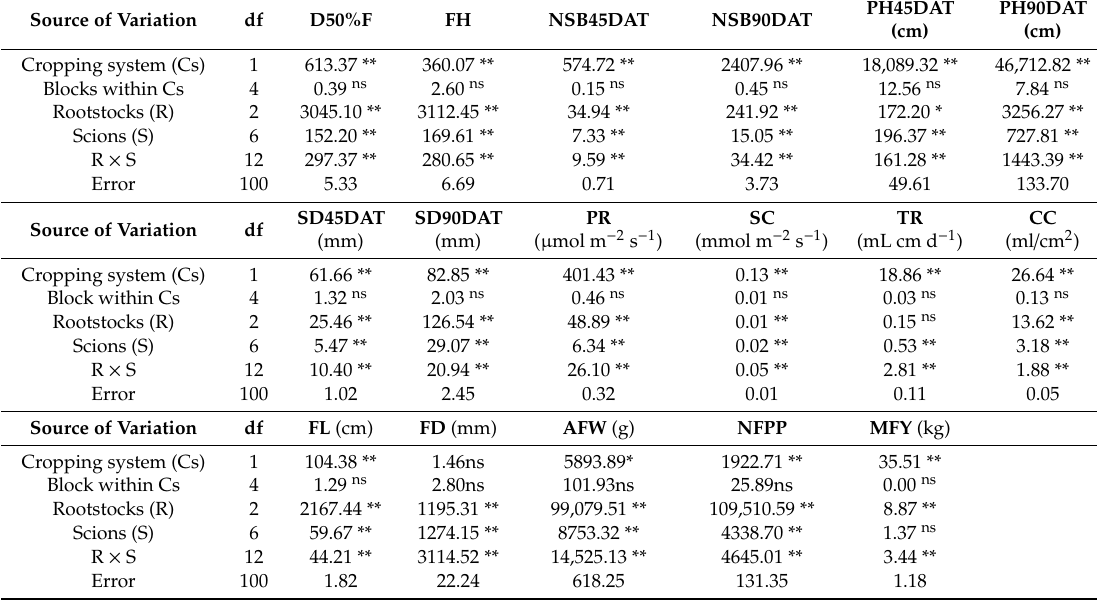
Table 2. Analysis of variance for interaction between rootstock and scion across cropping systems. Source of Variation df D50%F FH NSB45DAT Cropping system (Cs) 1 613.37 **